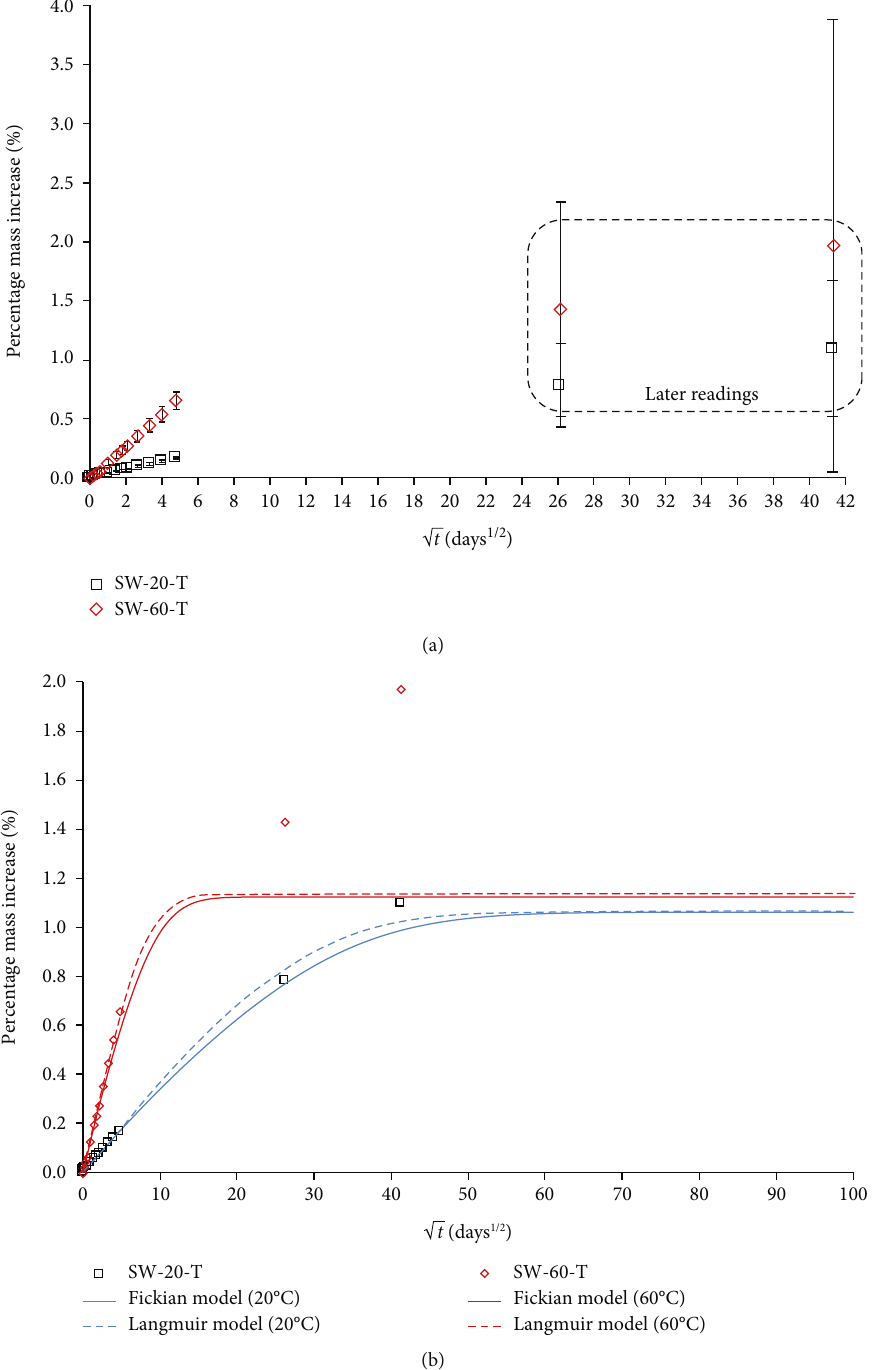
Figure 5: (a) Mass uptake in CFRP tendons at 20 ° C and 60 ° C and (b) Fickian and Langmuir